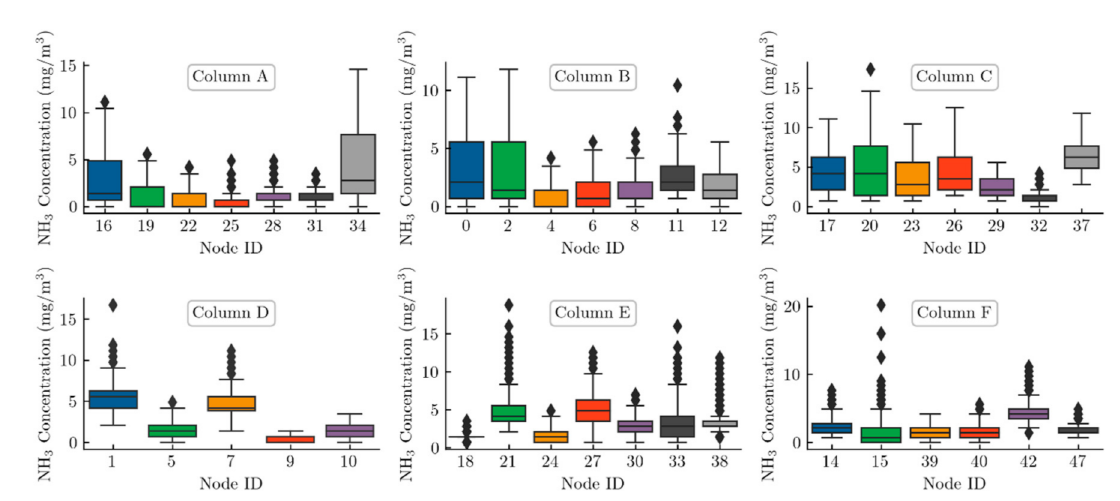
Figure 9. The boxplots of ammonia concentration recorded by the slave nodes that are distributed on six columns in the gestating sow house.